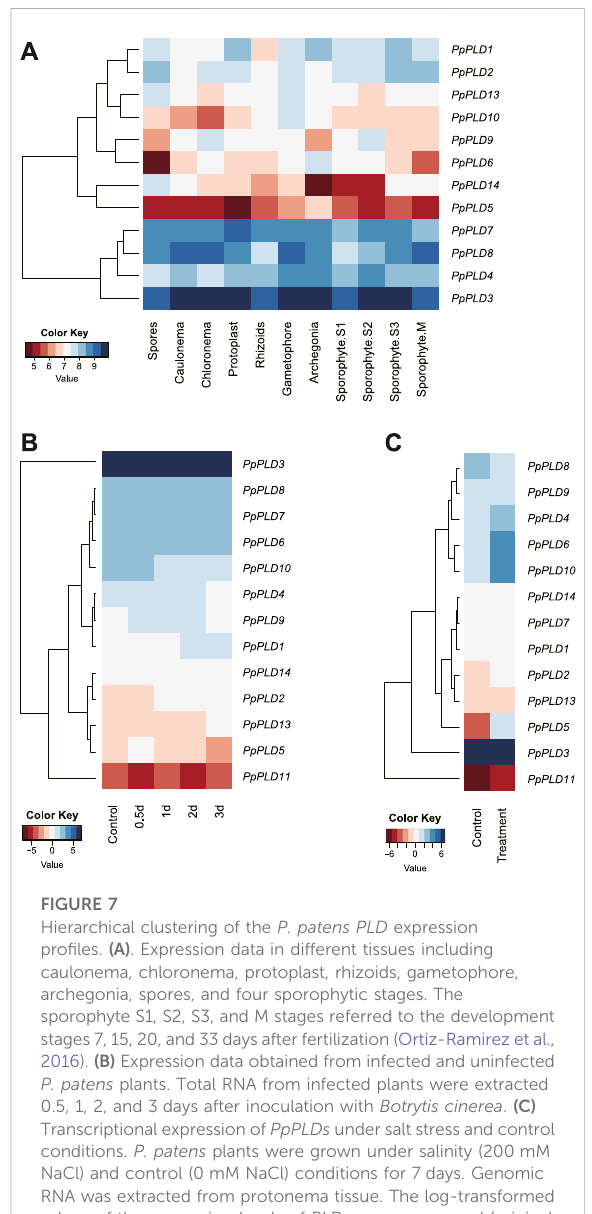
FIGURE 7 Hierarchical clustering of the P. patens PLD expression pro fi les. (A) . Expression data in different tissues including caulonema, chloronema, protoplast, rhizoids, gametophore, archegonia, spores, and four sporophytic stages. The sporophyte S1, S2, S3, and M stages referred to the development stages 7, 15, 20, and 33 days after fertilization (Ortiz-Ramirez et al., 2016). (B) Expression data obtained from infected and uninfected P. patens plants. Total RNA from infected plants were extracted 0.5, 1, 2, and 3 days after inoculation with Botrytis cinerea . (C) Transcriptional expression of PpPLDs under salt stress and control conditions. P. patens plants were grown under salinity (200 mM NaCl) and control (0 mM NaCl) conditions for 7 days. Genomic RNA was extracted from protonema tissue. The log-transformed values of the expression levels of PLD genes were used (original data are shown in Supplementary Table